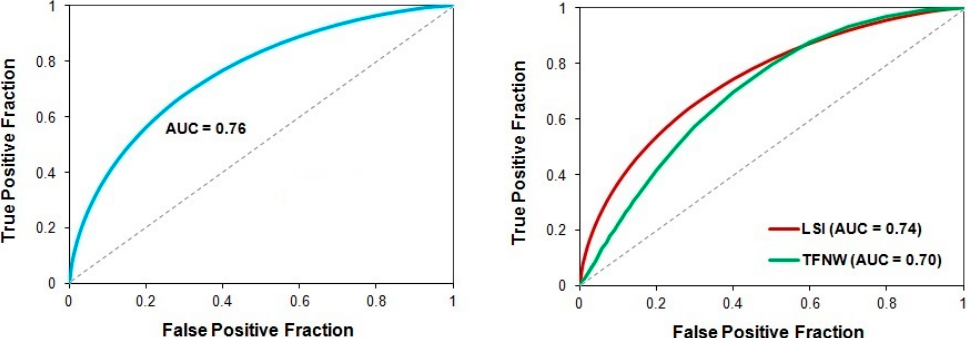
Figure 3. ROC curves for the integration LSI/TFNW model and the combined single models, LSI and TFNW. and